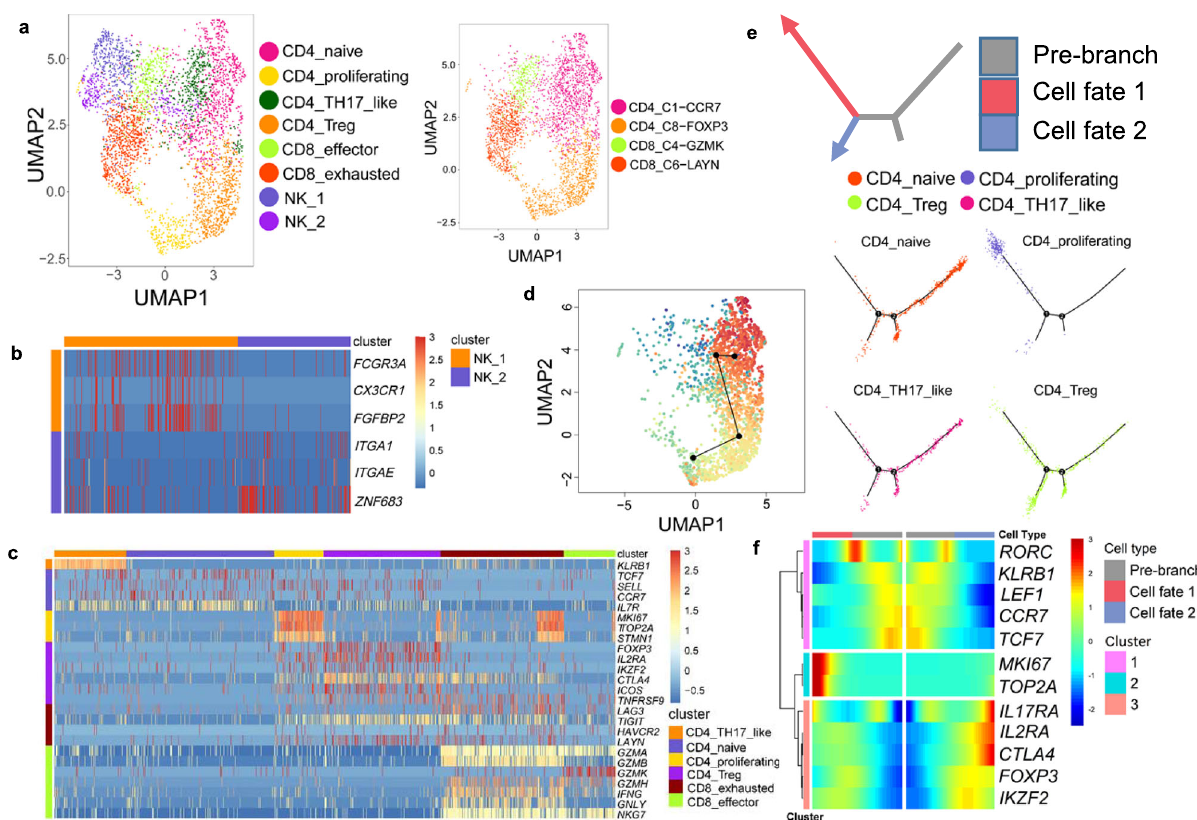
Fig. 4 Subtypes and developmental trajectory of T cells. a UMAP visualization of 6 T cell subtypes and 2 NK cell subtypes (left) and predicted T cell subtypes by singleR (right). b Heatmap of selected markers for 2 NK clusters. c Heatmap of T subtype markers and selected functional genes. d Transitional relationship among CD4 T cells predicted by Slingshot. Rainbow coloring from red to blue represented the begin to end of the trajectory. e Illustration of CD4 T cell differentiation pathways inferred by Monocle and the relative locations of each CD4 T subtypes along the development pathways. The red and blue arrows indicated the two pseudotime directions of cell development. The grey section represented the beginning of the trajectory before the branching point. f Heatmap showing relative expressions of canonical markers of CD4 T cells along inferred trajectories. The red and blue branches correspond to the two developmental directions in e